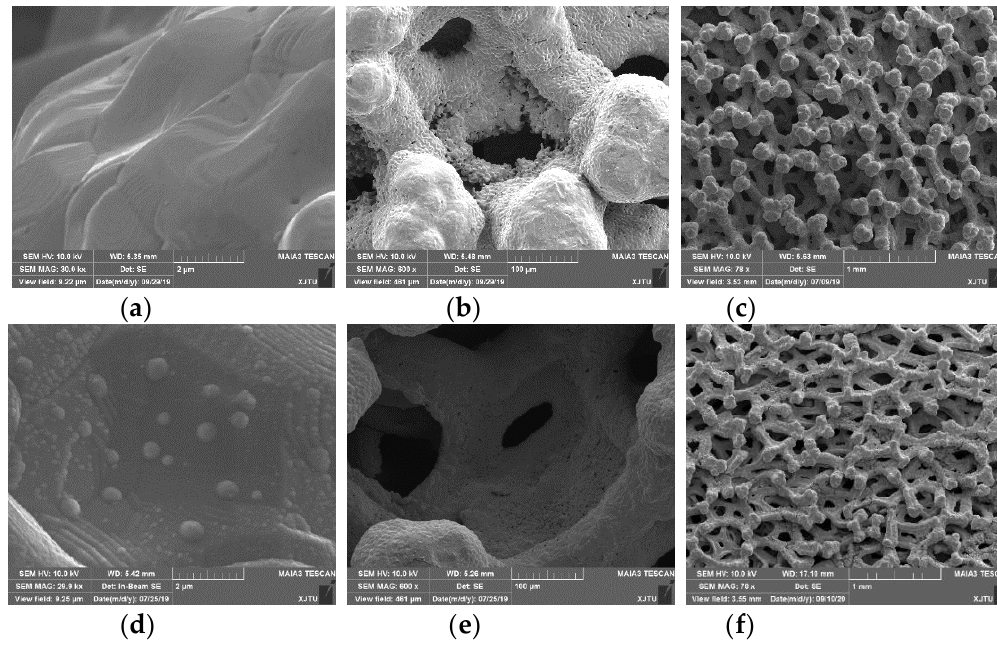
Figure 2. The SEM images of the OCMF substrates and Ti-Zr-V-Hf-coated OCMF. ( a ), ( b ) and ( c ) are the surface morphologies of the OCMF substrates with different magnifications of 30,000×, 600× and 78×. ( d ), ( e ) and ( f ) are the surface morphologies of Ti-Zr-V-Hf-coated OCMF substrates with different magnifications of 30,000×, 600× and 78×.